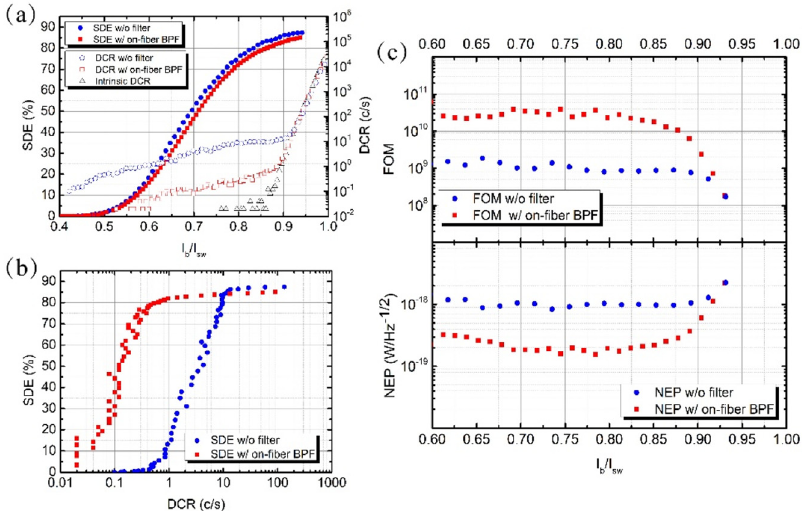
Figure 6: (a) Normalized bias-current dependence of SDE and DCR for an SNSPD coupled using a fiber with and without a BPFonitsend-face.TheintrinsicDCRofthe device is also plotted. (b) SDE as a function of DCR without (blue dots) and with (red squares) a BPF. (c) Top: figure of merit (FOM), FOM = SDE/(DCR × j sys ). Bottom: noise equivalent power (NEP) as a function of bias current for devices with/without end-face BPF, Reproduced with